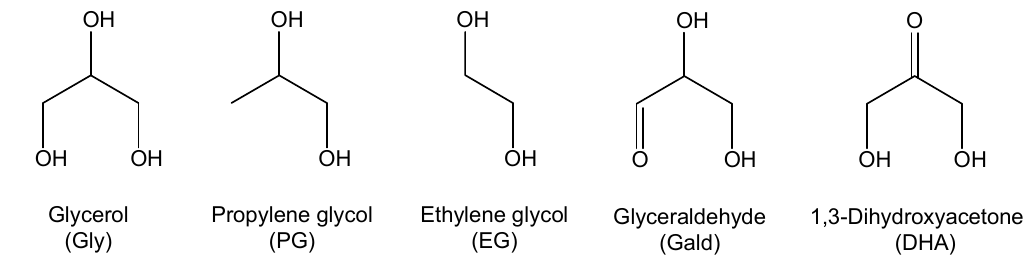
Figure 1. Polyalcohols used in the present investigation.